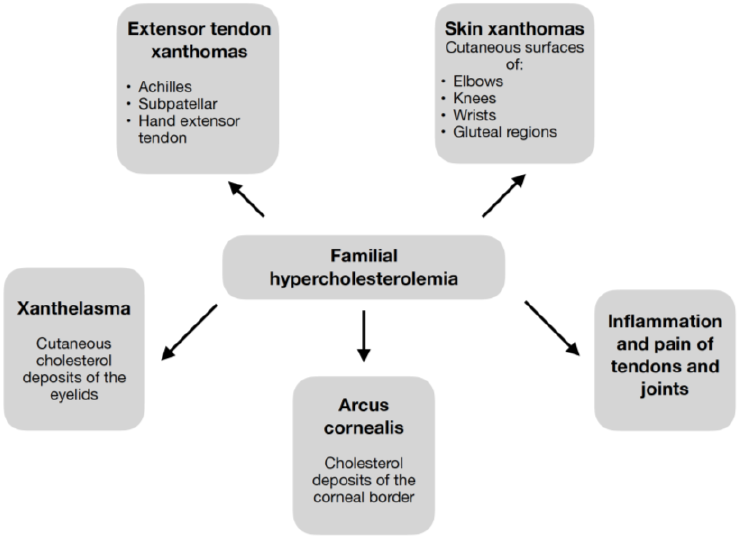
Figure 2. Symptoms Associated with Cholesterol Deposition in the Course of FH [2,3,5 –